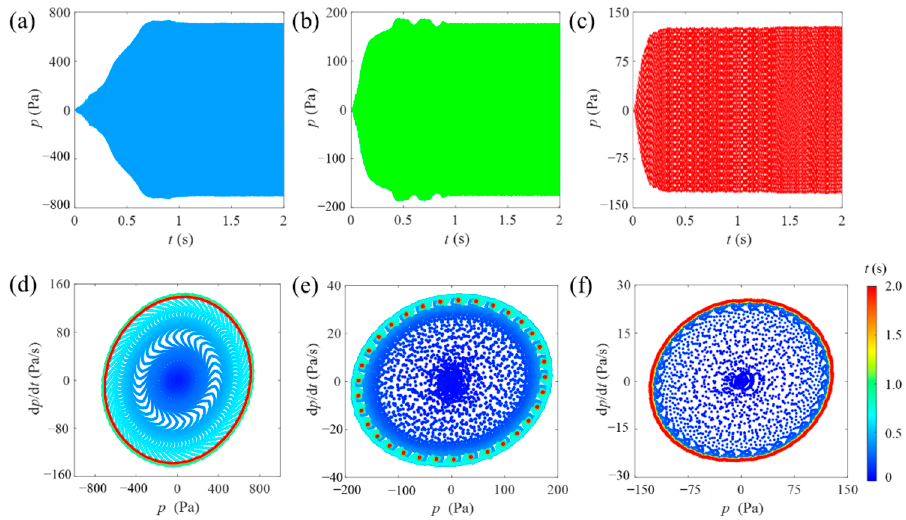
Figure 11. ( a – c ) Time domain signal of pressure fluctuations and ( d – f ) corresponding phase diagram. ( a , d ) T i = 300 K, ( b , e ) T i = 400 K, and ( c , f ) T i = 600 K, where S N = 0.6 and V a = 180 L/min.